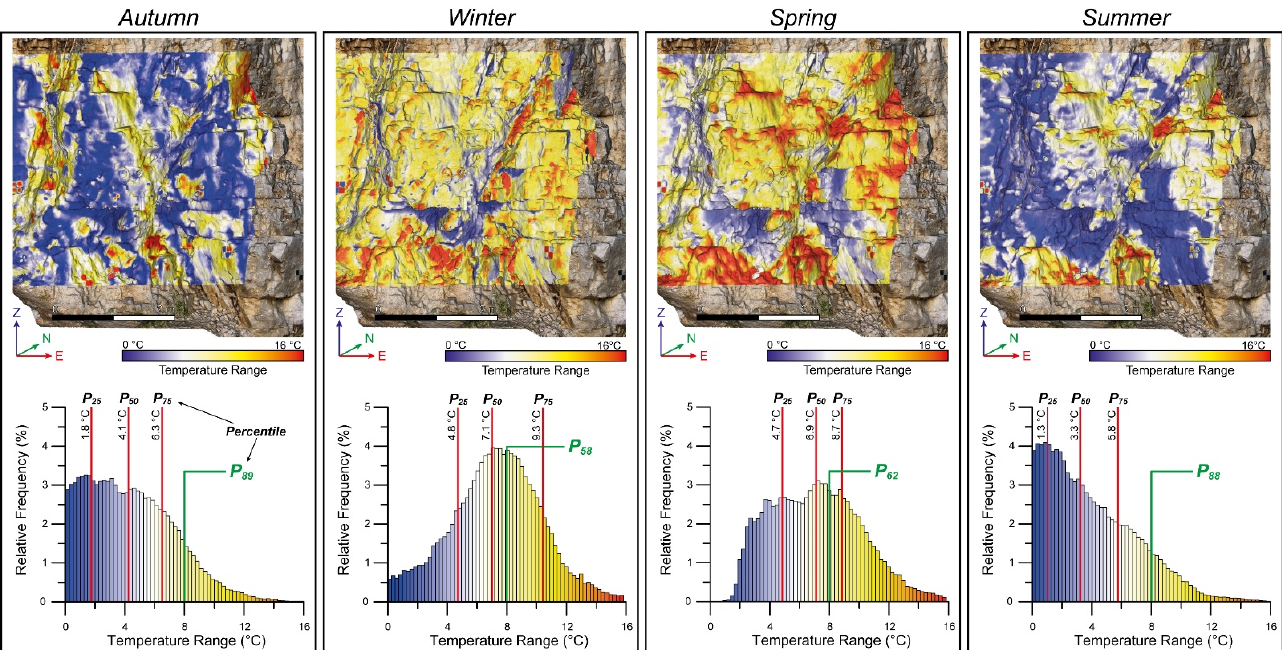
Figure 9. 3D color-scale visualization of daily temperature ranges of the investigated rock block computed for the autumn, winter, spring and summer survey. The respective histograms show how the amplitude and distribution of temperature ranges strongly vary under different climatic conditions. Three percentiles (P 25 , P 50 and P 75 ), along with the i-th percentile corresponding to a temperature range equal or greater than 8 ◦ C, are also presented to highlight the main differences between the four distributions of temperature